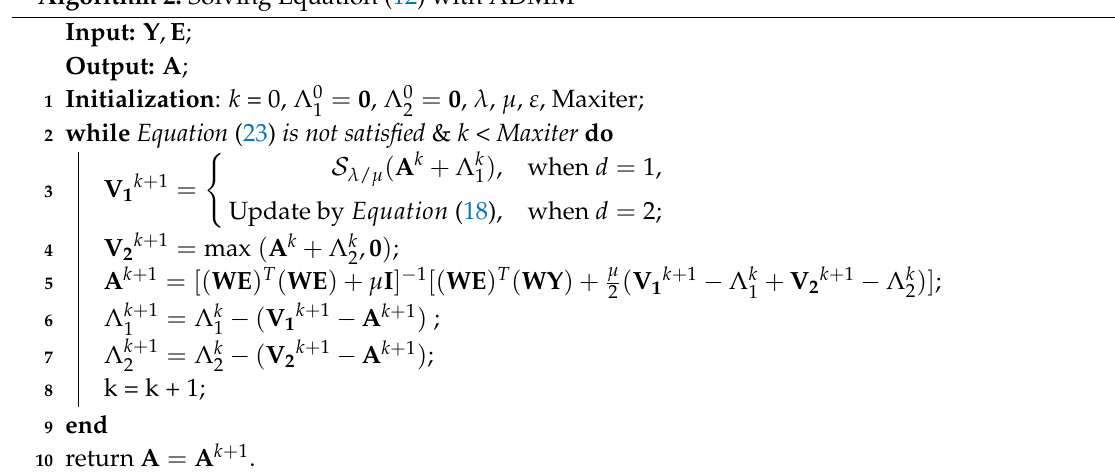
Algorithm 2: Solving Equation (12) with